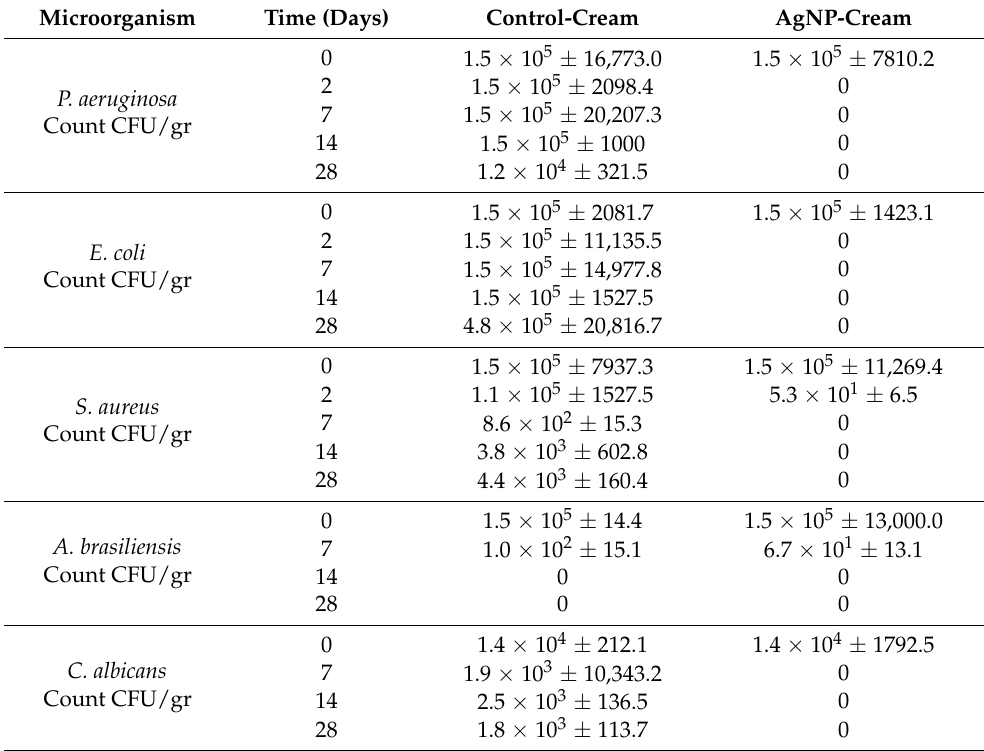
Table 4. Challenge test in formulated Control-Cream and